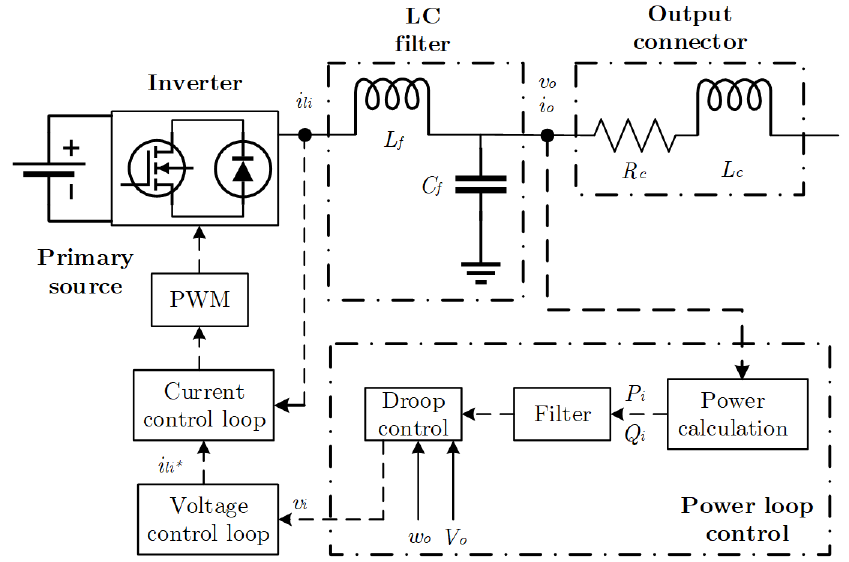
Figure 2. Single-phase inverter in islanding operation